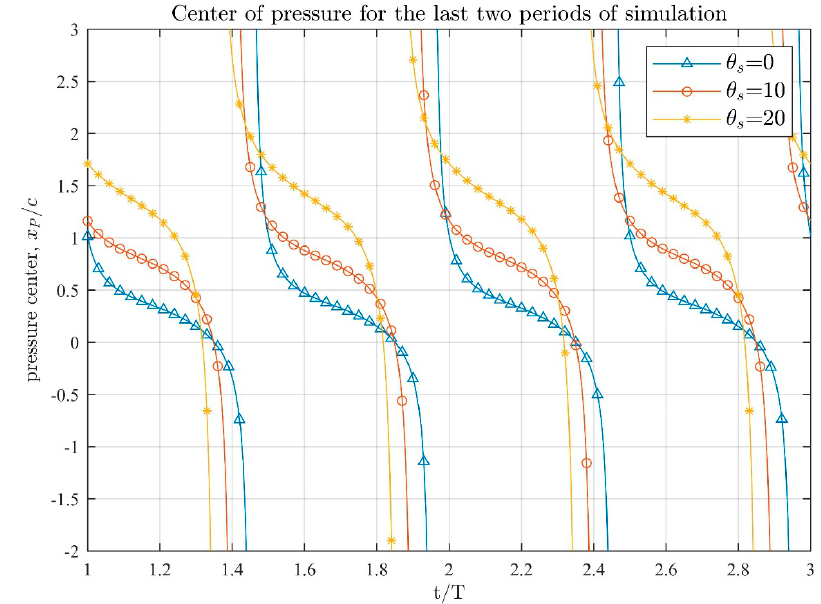
Figure 10. Effect of the sweep angle on the center of pressure. The sweep angle moves the average center of pressure further from the leading edge (LE) ( x P / c =